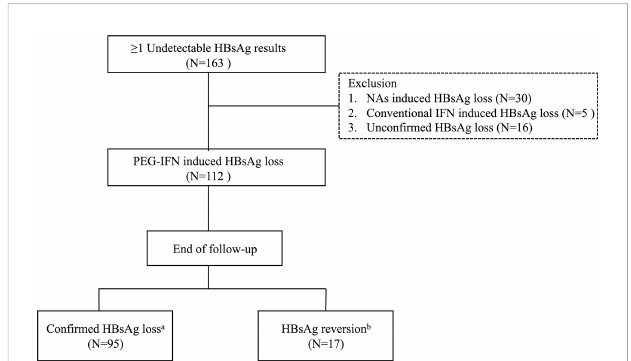
FIGURE 1 Flowchart of patients ’ selection process. HBsAg, hepatitis B surface antigen; NA, nucleos(t)ide analogue; IFN, interferon; PEG-IFN, pegylated interferon. a Two negative HBsAg results (<0.05 IU/mL) at least 6 months apart. b Reappearance of HBsAg after HBsAg